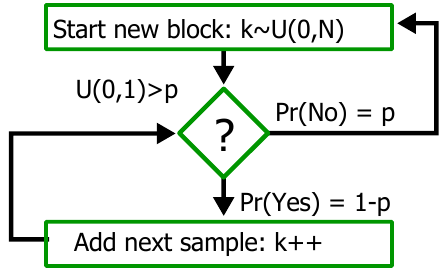
Figure 6: Simplified block diagram of Stationary Boot- strapping.